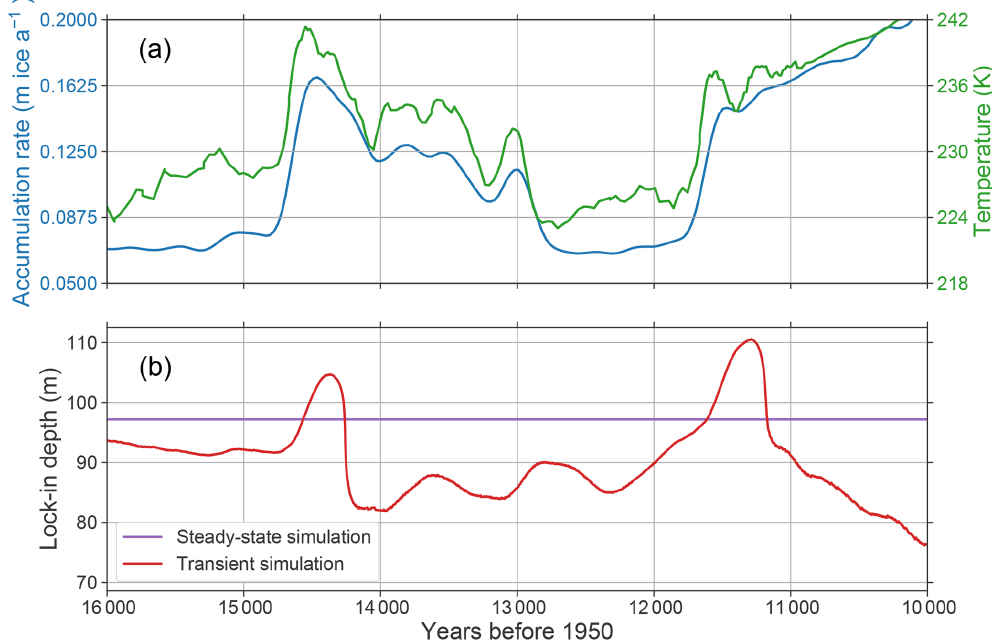
Figure 3. (a) Accumulation-rate and temperature histories derived from the GISP2 ice core (Alley, 2004; Cuffey and Clow, 1997) and used to force the CFM for the analyses in Sect. 4. (b) LID predicted by the steady-state and transient model simulations described in Sect. 4. The LID for the transient simulation is determined by running the CFM with the climate shown in (a) , and the LID for the steady-state simulation is that predicted by the Herron and Langway (1980) model with the accumulation rate 0 . 07miceeq.a − 1 and mean annual temperature − 47 . 5 ◦